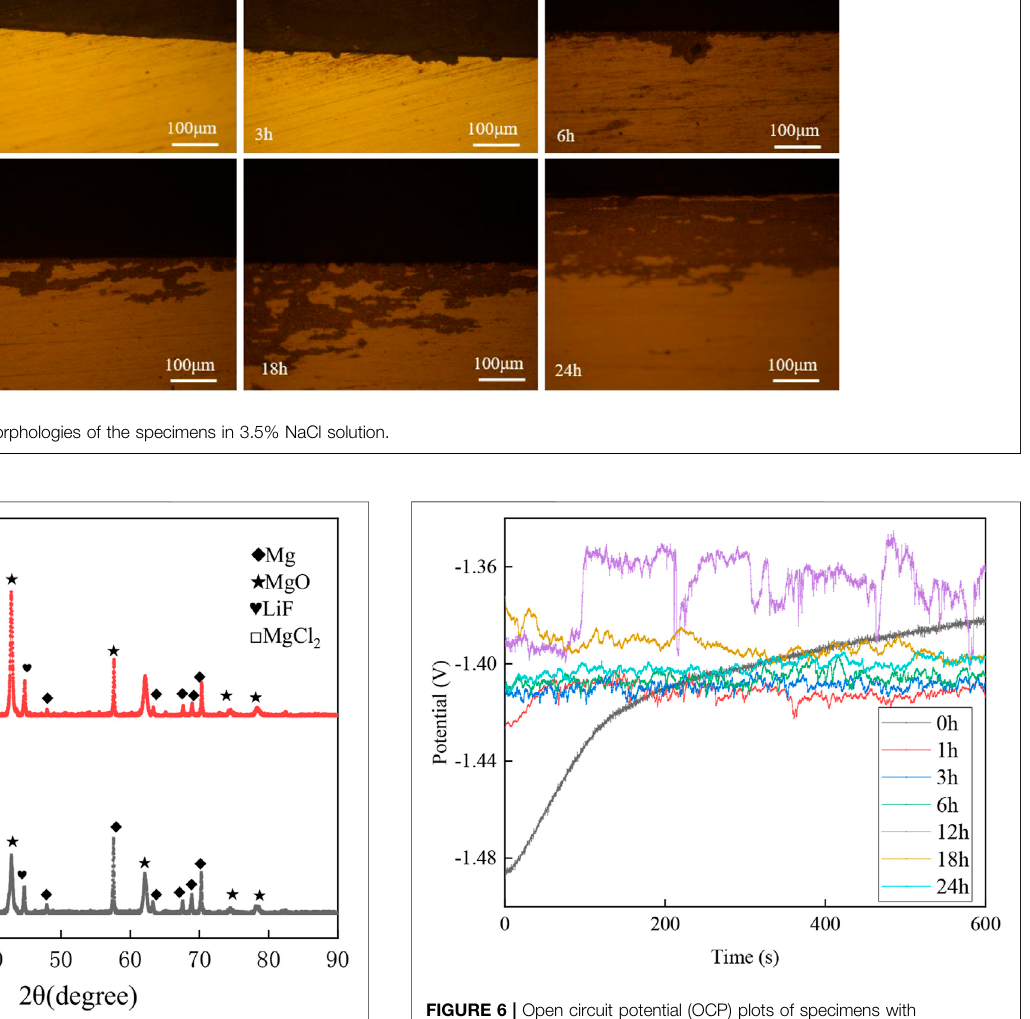
FIGURE 5 | XRD results of the specimens in 3.5% NaCl solution.